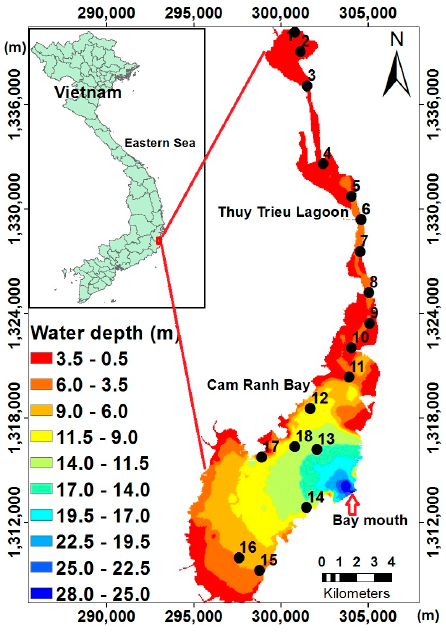
Figure 1. Location of the sampling stations (black points) and bathymetry of Cam Ranh Bay and Thuy Trieu Lagoon.